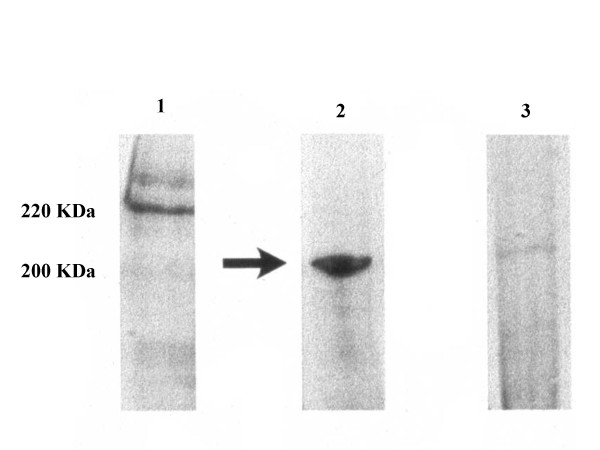
Western blotting using mAb SM5-1. Western blotting of the protein extracted from the SMMUpos cells with monoclonal antibody SM 5-1. 1: molecular weight standard; 2: SMMUpos; 3: SMMUneg.